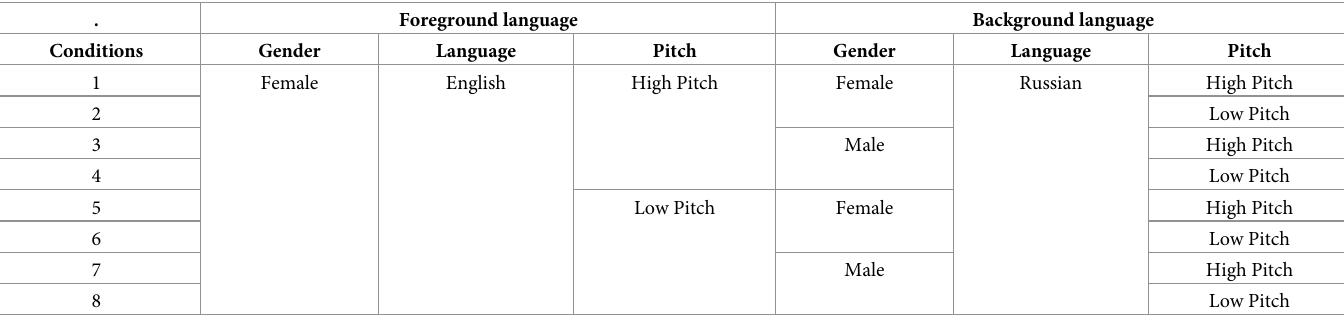
Table 2. Description of experiment conditions (Experiment 2).